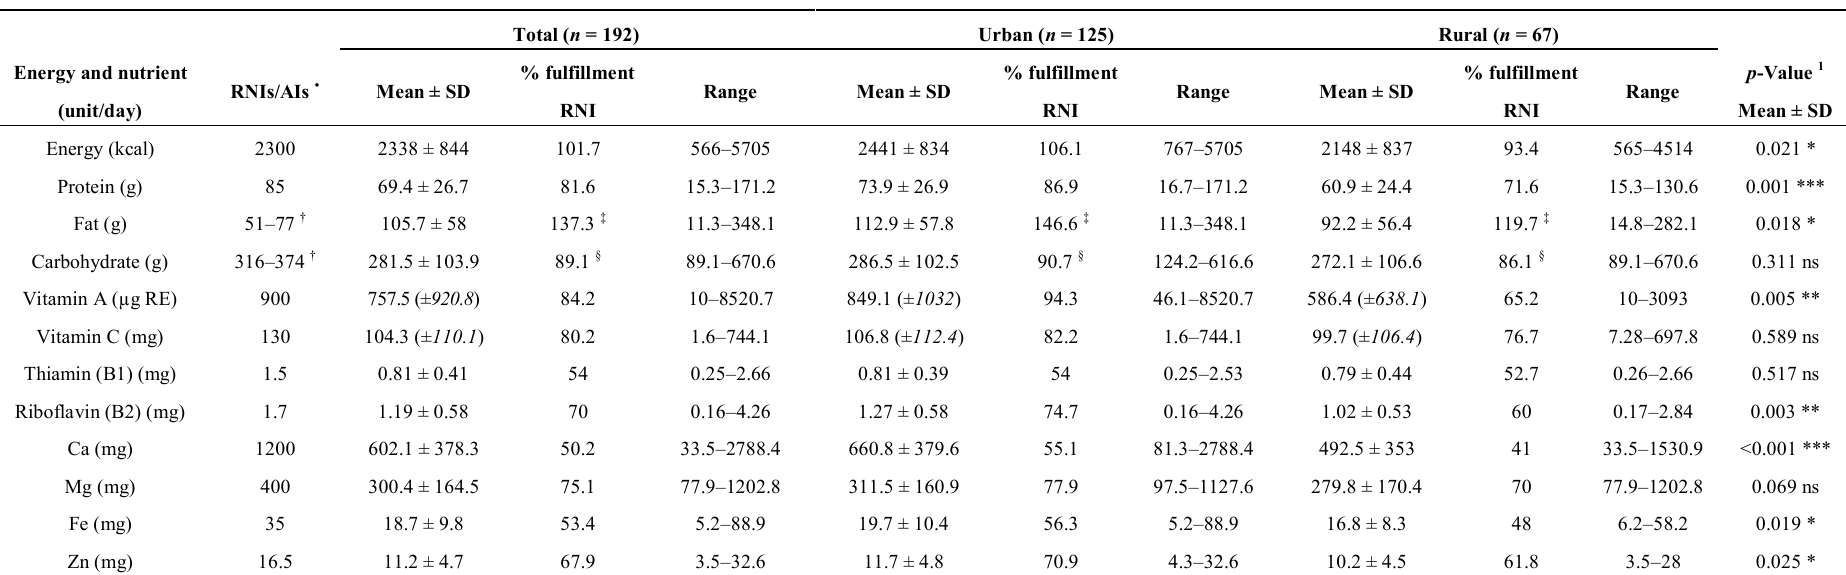
Table 3. Energy and nutrient intakes of rural and urban pregnant women in Deyang city in relation to fulfillment of the national recommended nutrient intakes (RNIs) (adopted by the INFSC